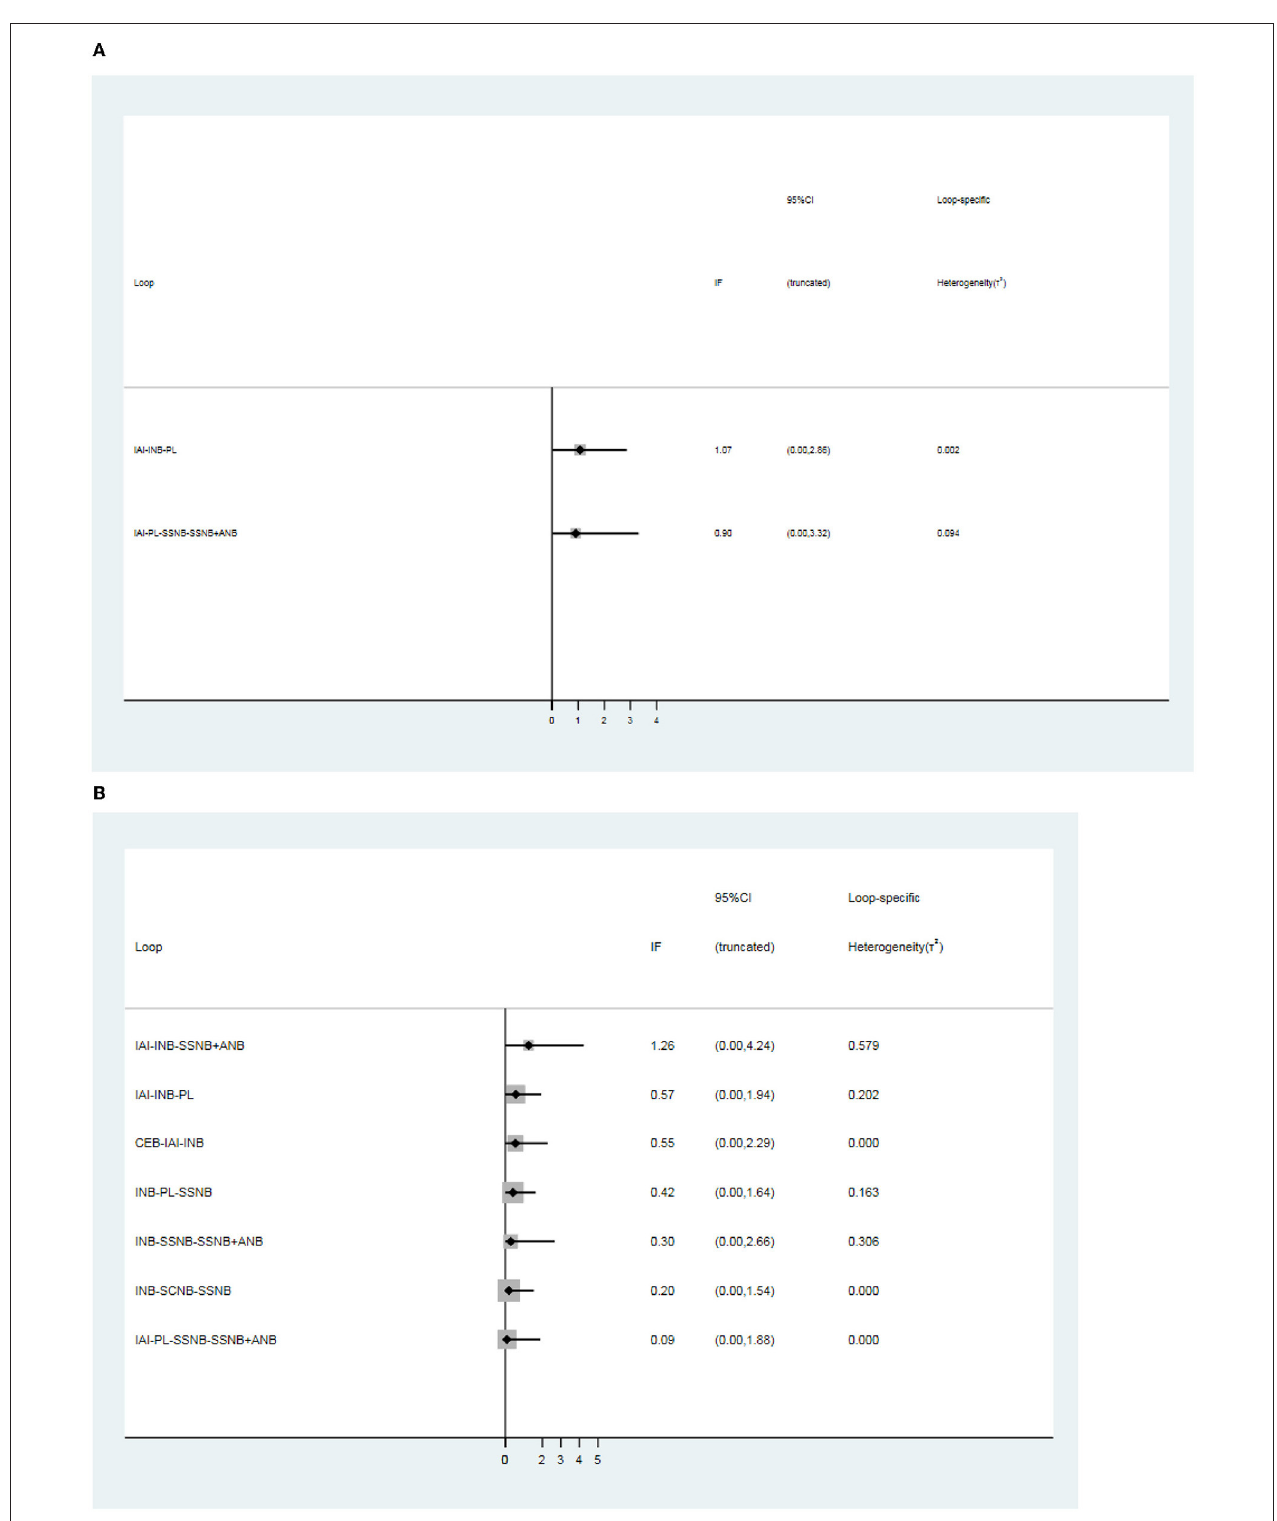
FIGURE 6 | Loops analysis for inconsistency of network meta-analysis. [ (A) postoperative 12h., (B) postoperative 24h]. When the 95% confidence interval (CI) includes 0; it means that inconsistency is low risk. INB, interscalene nerve block; SCNB, supraclavicular nerve block; SSNB, suprascapular nerve block; CEB, cervical epidural block; ANB, axillary nerve block; IAI, intra-articular injection; PL, placebo.